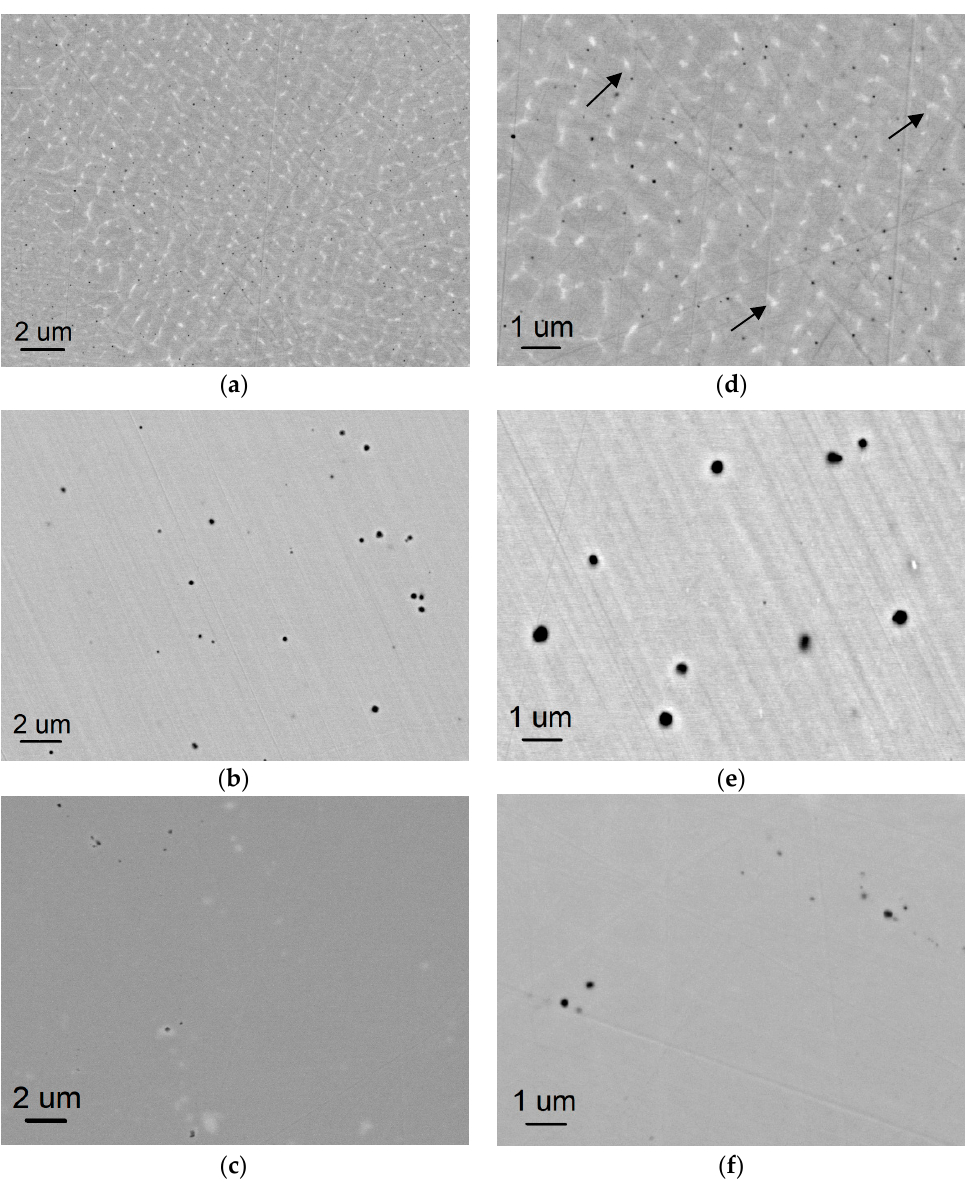
Figure 1. BSE images obtained from the AM- and SPS-fabricated substrates, ( a , b ) represent the IN718 samples processed by SLM and EBM, respectively, ( c ) is SPS-consolidated IN718 alloy. ( d – f ) are correspondingly magnified BSE images.